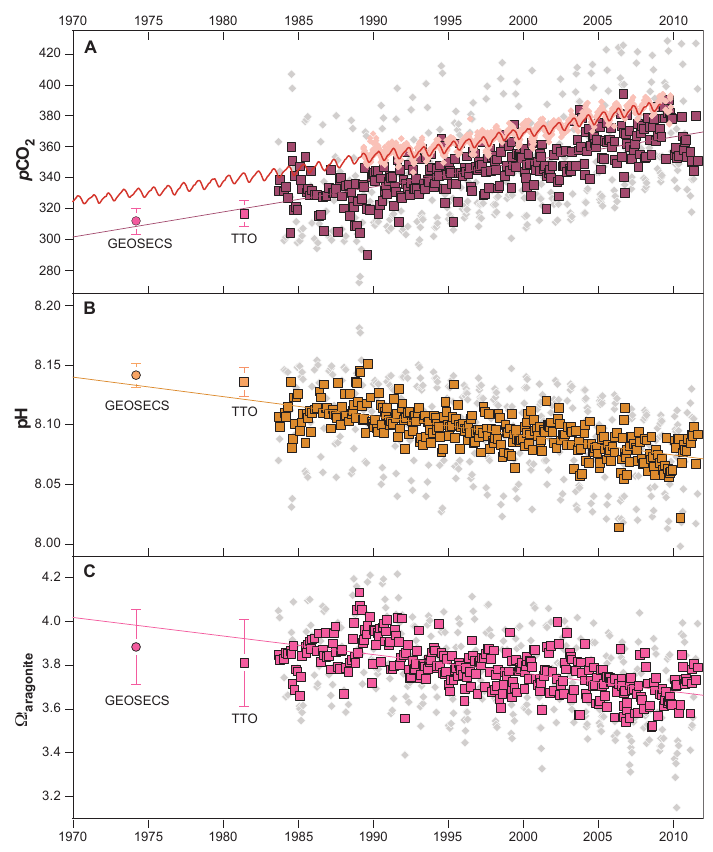
Figure 8 Fig. 8. Time-series of atmospheric and ocean p CO 2 , pH and aragonite saturation states. (A) time-series of atmospheric p CO 2 (ppm) from Mauna Loa, Hawaii (red line), and Bermuda (pink symbol), and surface ocean seawater p CO 2 (µatm) at the Bermuda Atlantic Time-series Study (BATS) site off Bermuda. Observed (grey) and seasonally detrended (purple) surface ocean seawater p CO 2 levels are shown. Earlier seawater data from the GEOSECS (stations 67 ◦ 58 ◦ W, 33 ◦ 59 0 N; 56 ◦ 33 0 W, 33 ◦ 20 0 N) and TTO (stations 67 ◦ 21 ◦ W, 34 ◦ 41 0 N; 61 ◦ 20 ◦ W, 34 ◦ 42 0 N; 56 ◦ 11 0 W, 32 ◦ 08 0 N) expeditions in the North Atlantic Ocean are also shown in this and following panels. (B) time-series of surface ocean seawater pH at the BATS site off Bermuda. Observed (grey) and seasonally detrended (orange) seawater pH are shown. (C) . time-series of surface ocean aragonite saturation state ( (cid:127) aragonite ) for calcium carbonate at the BATS site off Bermuda. Observed (purple) and seasonally detrended (purple line) seawater (cid:127) aragonite are